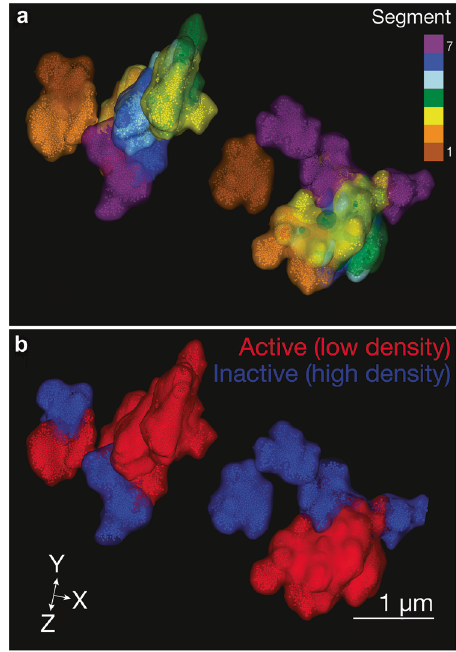
Fig. 4 OligoSTORM image of chromatin density. (a) Seven chromo- somal segments (chr19:8.68 – 15.2; hg19) rendered as isosuurface clusters in a PGP1 fi broblast. Each color represents a different chromosomal segment. (b) The seven segments color-coded according to their transcriptional activity and epigenetics marks 51 (blue — inactive, red — active). Here, the density of the inactive is higher than the active